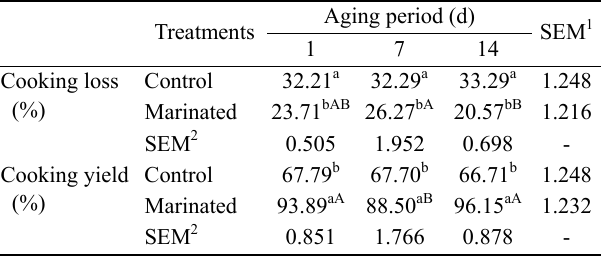
Table 4. Effect of aging and marination on cooking loss and yield of duck breast meat